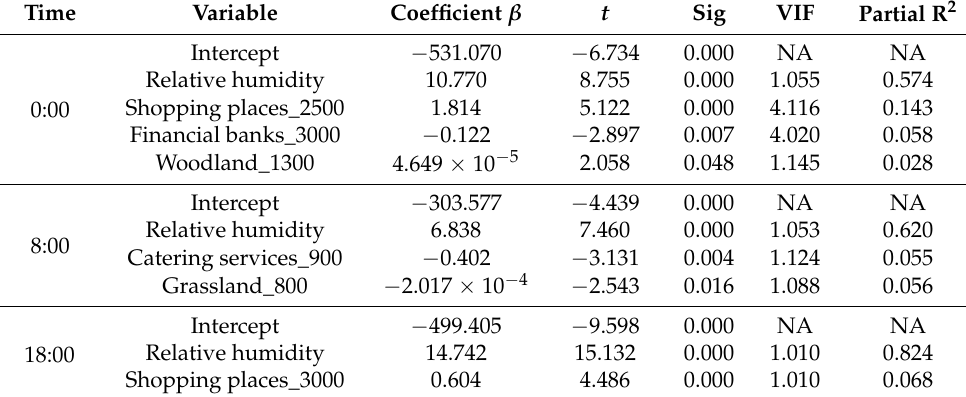
Table 5. The LUR models at different times during a winter non-working day. Time